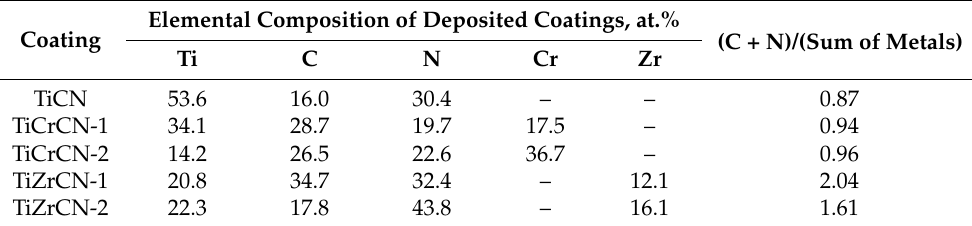
(C + N)/(Sum of Metals)